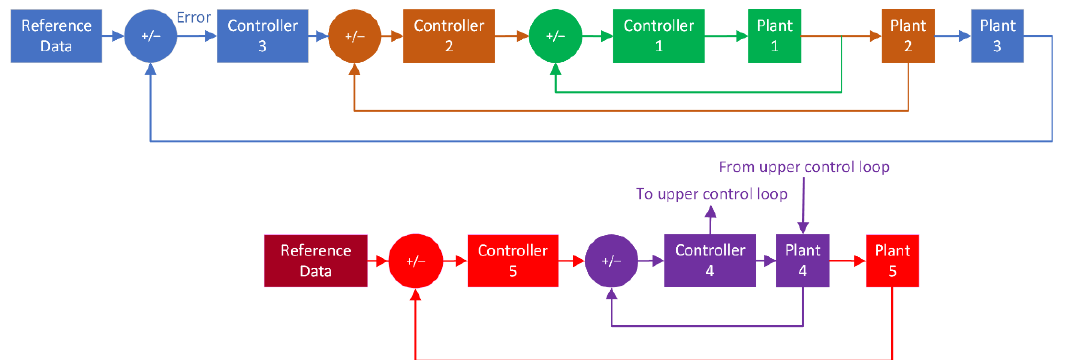
Figure 5. Aircraft model control structure overview.